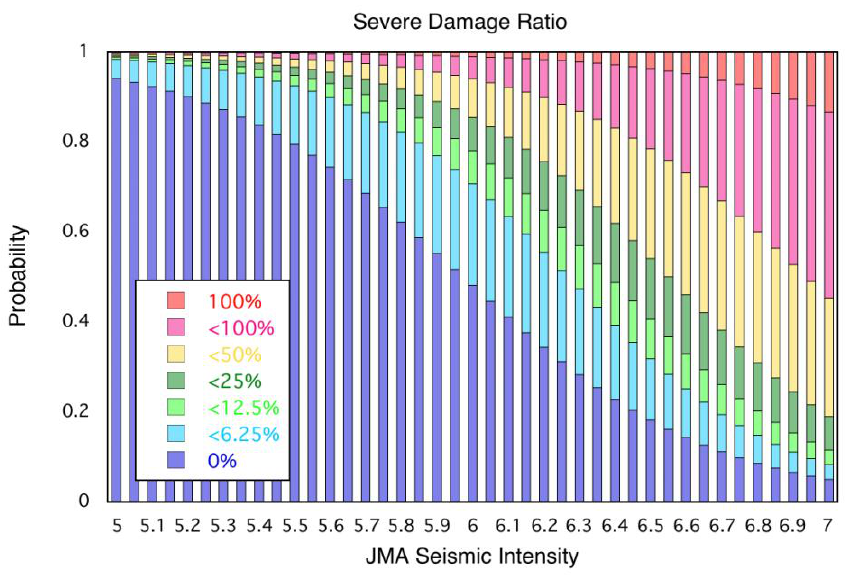
Figure 7. Fragility function derived from the Kobe earthquake dataset